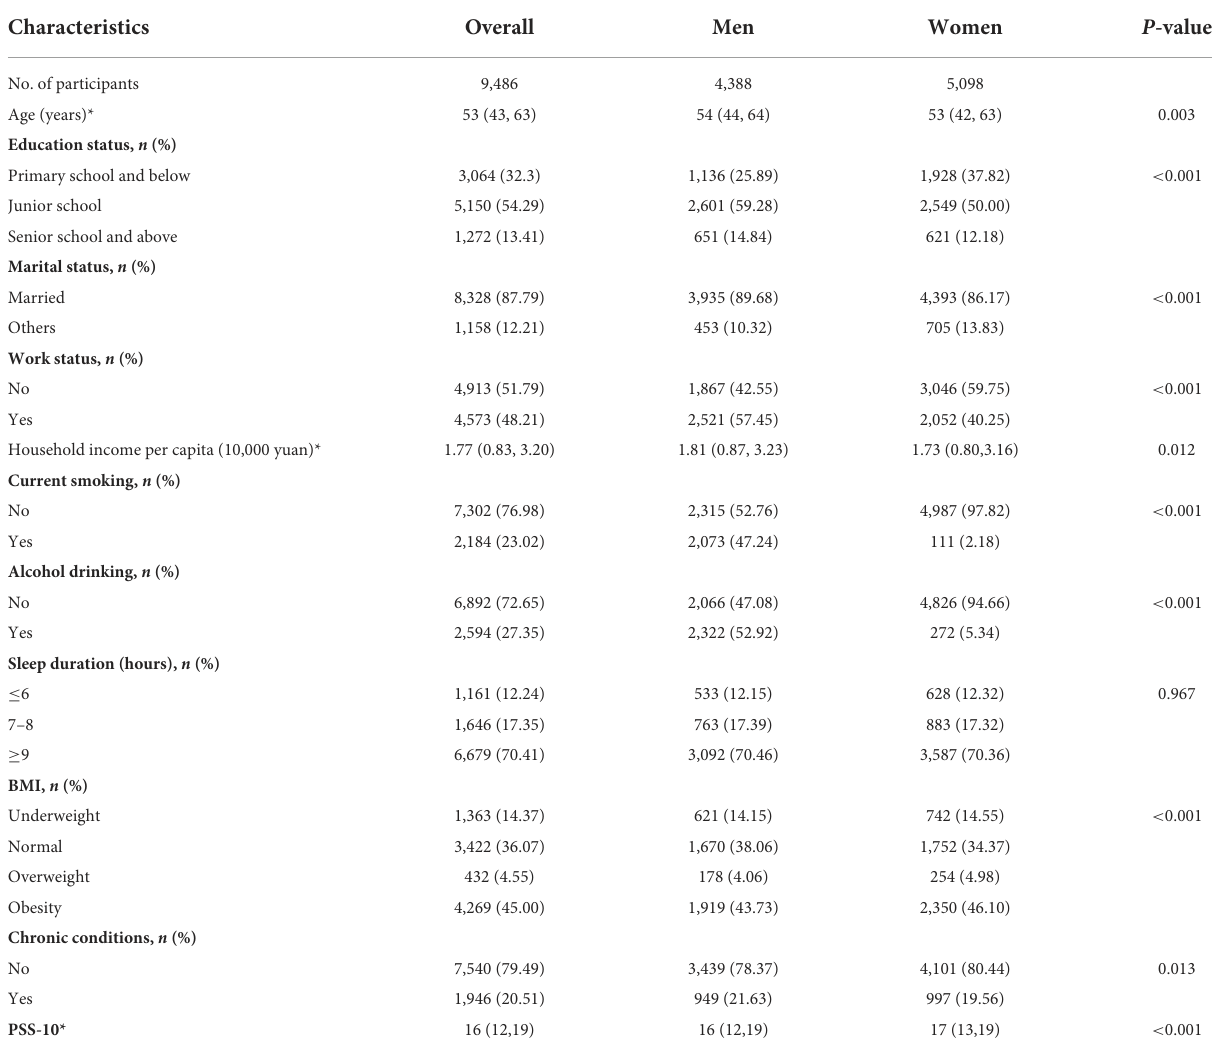
TABLE 1 Characteristics of the study